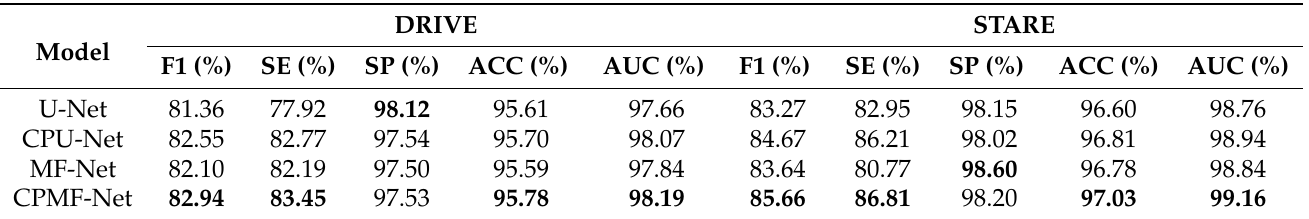
Figure 7. Model segmentation results using different training strategies. The top row is based on DRIVE datasets, and the bottom row is STARE datasets. ( a ) The original image, ( b ) the ground truth, ( c ) the segmentation result of U-Net, ( d ) the segmentation result of CPU-Net, ( e ) the segmentation result of MF-Net and ( f ) the segmentation result of our CPMF-Net. Table 2. Quantitative comparison of the performance of different training methods in segmenta- tion